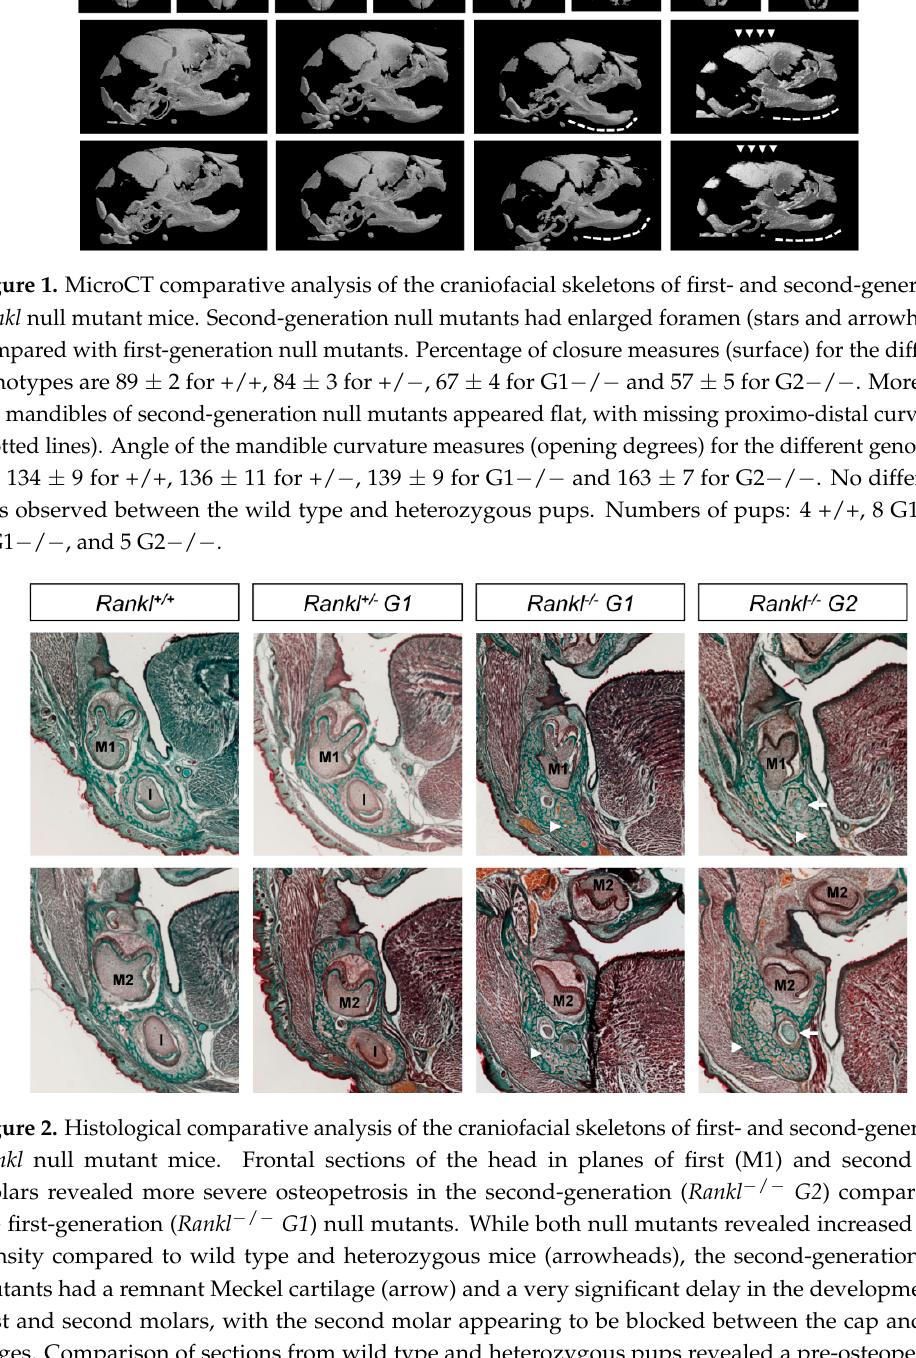
Figure 2. Histological comparative analysis of the craniofacial skeletons of first- and second-generation Rankl null mutant mice. Frontal sections of the head in planes of first (M1) and second (M2) molars revealed more severe osteopetrosis in the second-generation ( Rankl − / − G2 ) compared to the first-generation ( Rankl − / − G1 ) null mutants. While both null mutants revealed increased bone density compared to wild type and heterozygous mice (arrowheads), the second-generation null mutants had a remnant Meckel cartilage (arrow) and a very significant delay in the development of first and second molars, with the second molar appearing to be blocked between the cap and bell stages. Comparison of sections from wild type and heterozygous pups revealed a pre-osteopetrotic phenotype in the heterozygous mice, with increased bone density and delayed moving back of the incisor (I) in the mandible. Magnification 40 × for all images. Numbers of pups: 4 +/+, 8 G1+/ − , 5 G1 − / − , and 5 G2 − / − .